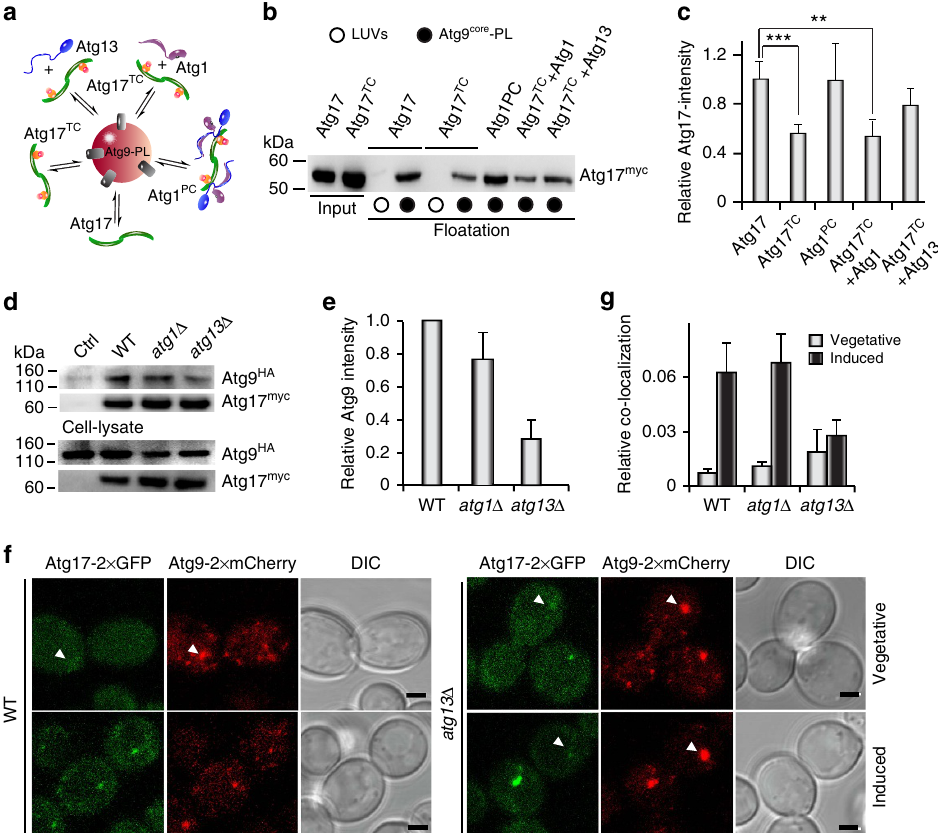
Figure 4 | The activity of Atg17 is regulated by Atg31–Atg29 and Atg1–Atg13 subcomplexes in vitro and in vivo. ( a ) The schematic drawing illustrates the experimental set-up of floatation assays. ( b ) a -myc immunoblot from co-floatation experiments of Atg9–PLs with recombinant myc-tagged Atg17 with and without other Atg1 PC -subunits as indicated. Similar experiments with large unilamellar vesicles (LUVs) lacking Atg9 core served as controls for unspecific membrane binding. Input corresponds to 10% of total protein used for co-floatation. ( c ) Semiquantitative analysis of immunoblots as shown in b from co-floatation experiments of Atg17 myc with Atg9–PLs in the presence of other subunits of Atg1 PC as indicated. All Atg17 myc -intensities were corrected for Atg9-intensities. The band intensity of Atg17 myc (w/o other Atg1 PC -subunits) was set to one and used for normalization. Mean values ± s.d. of N ¼ 3 independent experiments are shown. P values were calculated using two-tailed Student’s T -test (* P o 0.05; ** P o 0.01; *** P o 0.005). ( d ) Immunoprecipitation (IP) of Atg17 myc from lysates of wildtype (WT), atg1 D and atg13 D cells after two hours of starvation. Atg17 and co-immunoprecipitated Atg9 were detected by a -myc and a -HA immunoblots as indicated. ( e ) Quantification of Atg9 HA as shown in d . The intensity of the Atg9 HA -band in wildtype (WT), atg1 D , and atg13 D cells were corrected for unspecific binding of Atg9 HA in the control (Ctrl, cells w/o myc-tag). The WT Atg17-band intensity was set to one and used for normalization. Mean values ± s.d. of N ¼ 3 independent experiments are shown. ( f ) Co-localization of Atg9-tandem-mCherry with Atg17-tandem-GFP in wildtype (WT) and atg13 D cells under vegetative and autophagy-induced conditions. Arrowheads indicate positions of non-colocalizing Atg9-puncta. Scale bar, 2 m m. ( g ) Quantification of relative co-localization of Atg17-puncta with Atg9-puncta (number of co-localizing puncta per cell, normalized by number of Atg17 puncta per cell) in WT, atg1 D , and atg13 D cells under vegetative (white bars) and autophagy-induced (black bars) conditions. Mean values ± s.d. of N ¼ 3 independent experiments are shown ( 4 200 cells per strain were